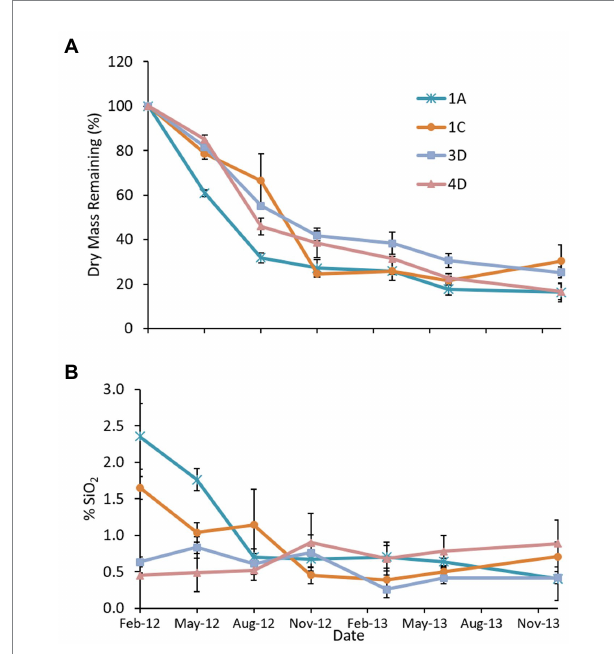
FIGURE 3 Results of the 2012–2013 Spartina alterniflora litter decomposition study showing (A) mean ( n = 3 litter bags) percent remaining dry weight, and (B) litter SiO 2 concentration in four marshes at Poplar Island. Cells 3D, 1A and 1C are dredged material marshes; in Cell 4D the substrate is sand. Error bars represent standard